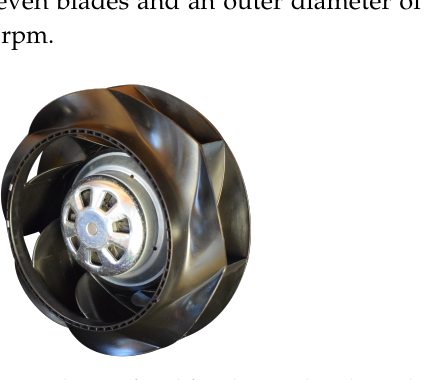
Figure 1. Photograph of the investigated centrifugal fan depicted without the spiral housing.